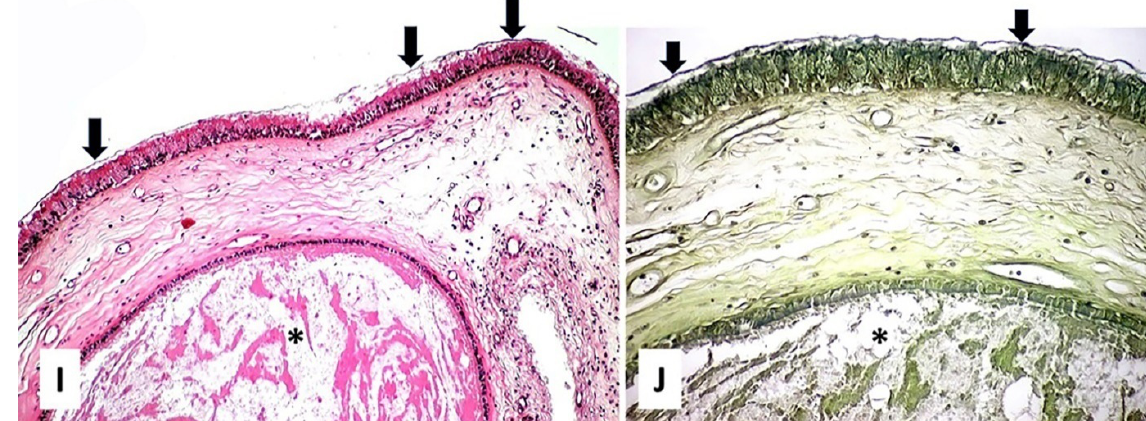
Figure 1. Pathology of CRSwNP: ( A )—macroscopic aspect of edematous ethmoidal mucosa: edema generated a polypoid appearance (surgical resection fragment during FESS); ( B )—interstitial edema with cystic mucus accumulation (mucocele) marked with arrow (HE ob. 4×); ( C )—on the background of mucosal edema, focally, there is a mixed inflammatory infiltrate, consisting of mature lymphocytes mixed with plasma cells (HE ob. 40×); ( D )—eosinophilic inflammatory infiltrate, cluster with eosinophils marked with arrow (HE ob. 20×); ( E )—squamous metaplasia and thickening of the basal membrane (arrows) (HE ob. 4×); ( F )—a detail of the squamous metaplasia shows no squamous layer and the presence of a hyperplastic basal and granular layer with some inflammatory cells migrated in the stratified epithelium (HE ob. 40×); ( G )—basal membrane thickening (arrow) with some minimal inflammation in the lamina propria (HE ob. 10×); ( H )—basal membrane thickening (arrow) with complete resolution of the inflammation (HE ob. 10×); ( I )—chorionic fibrosis, biofilm on the surface epithelium (arrows), mucocele formation marked with * (HE ob. 40×); ( J )—detail of the biofilm—bacteria covered by extracellular polysaccharide substance (arrows), mucocele formation marked with * (Gram ob. 40×).